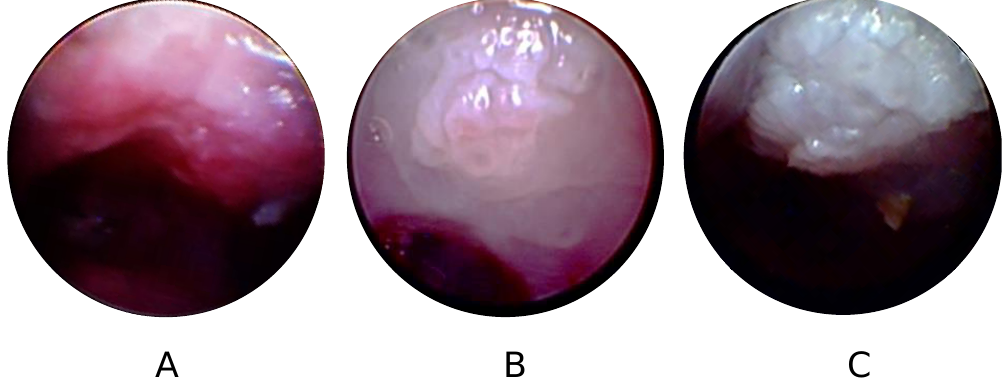
Figure 5. Longitudinal endoscopy reveals tumor growth. ( A ) The soft palate of an uninfected nude mouse injured with a Greer Pick and observed by endoscopy, in conjunction with Mickey’s Space ( B ) and 19 weeks ( C ) after infection with 3 × 10 9 genome equivalents of